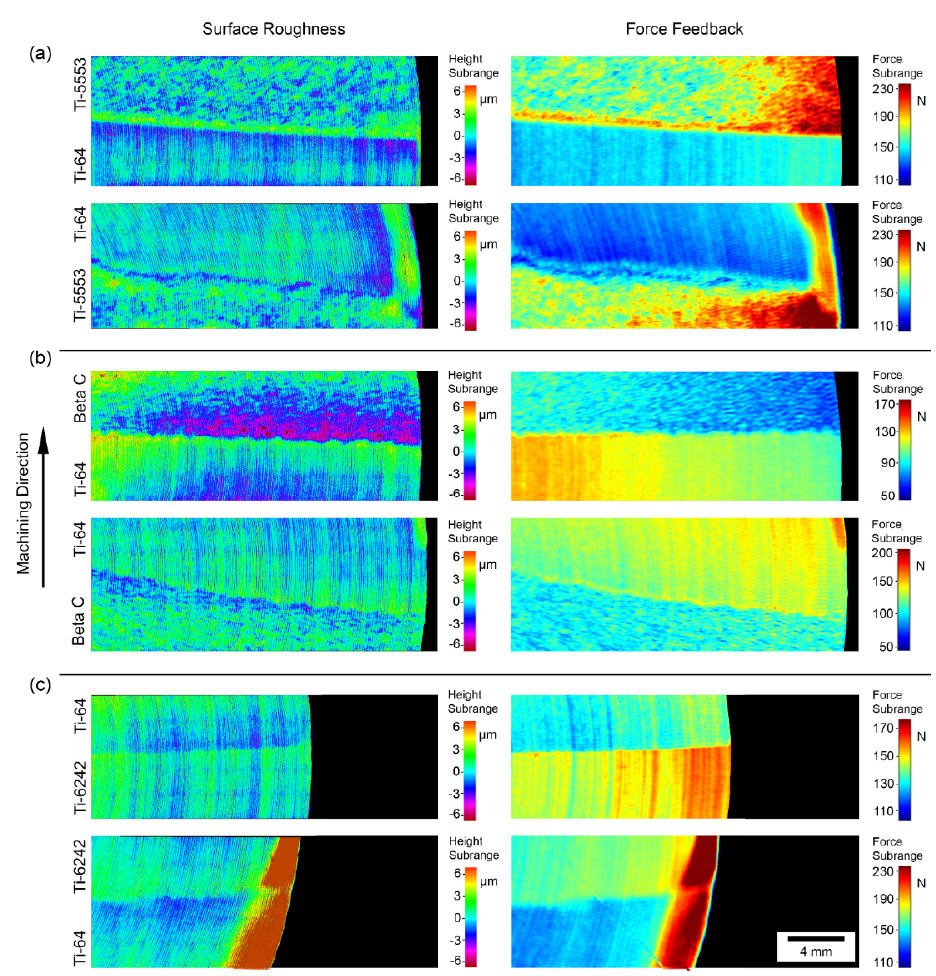
Figure 8. Surface topography and force feedback reconstruction plots at equivalent locations com ‐ paring the force and the surface roughness of the Ti ‐ 64 diffusion bond pairings in both machining directions. ( a ) Ti ‐ 64/Ti ‐ 5553, ( b ) Ti ‐ 64/Beta C and ( c ) Ti ‐ 64/Ti ‐ 6242.